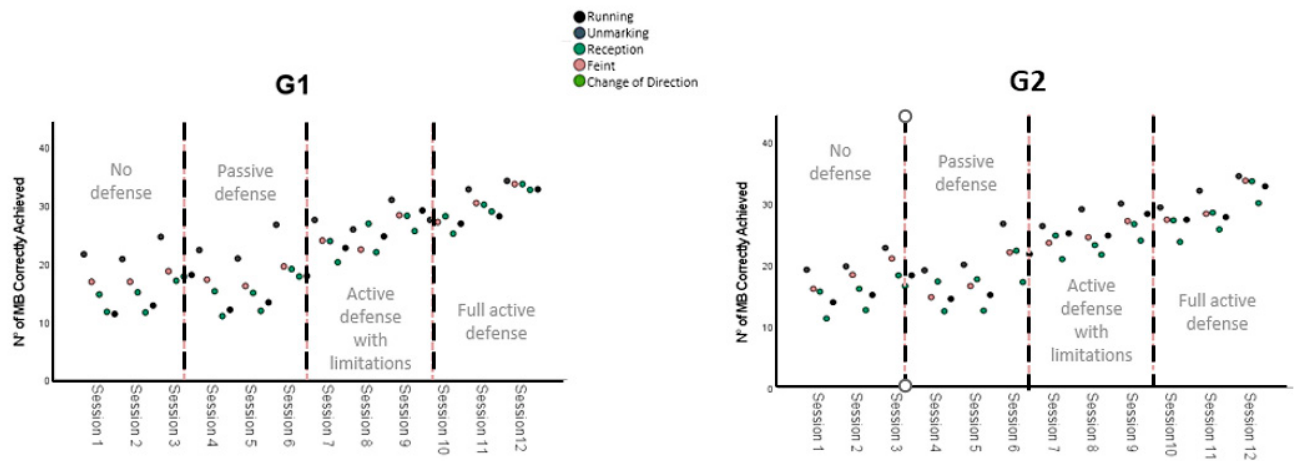
Figure 1. Evolution of the variables of G1 and G2: running, unmarked, reception, feint, and change of direction 4.